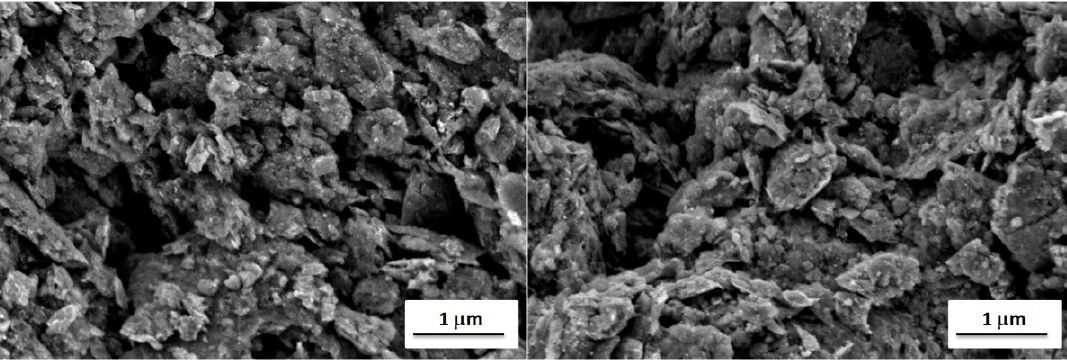
Figure 6. SEM images of gold electrodes with GO I ( left ) and GO II ( right ).